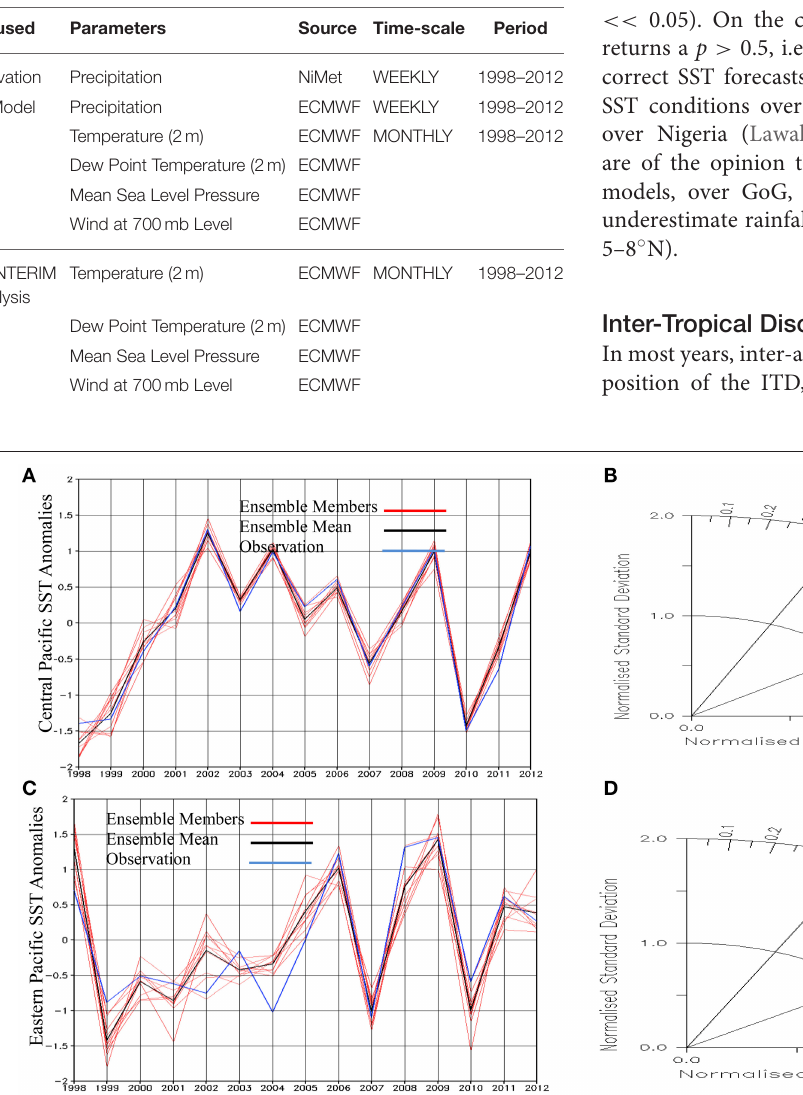
Frontiers in Environmental Science |